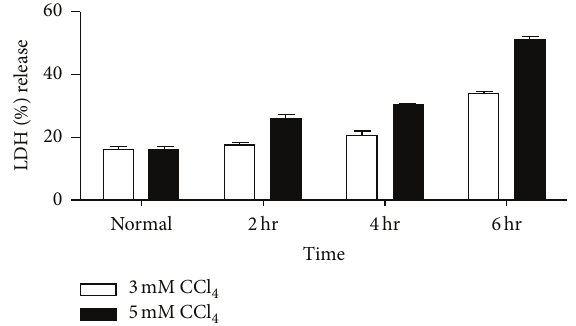
Figure 3: LDH assay of normal hepatocytes, CCl 4 injured hepato- cytes (3mM, 5 mM) for 2 hrs, 4 hrs, and 6hrs. pretreated and untreated MSCs were labeled with